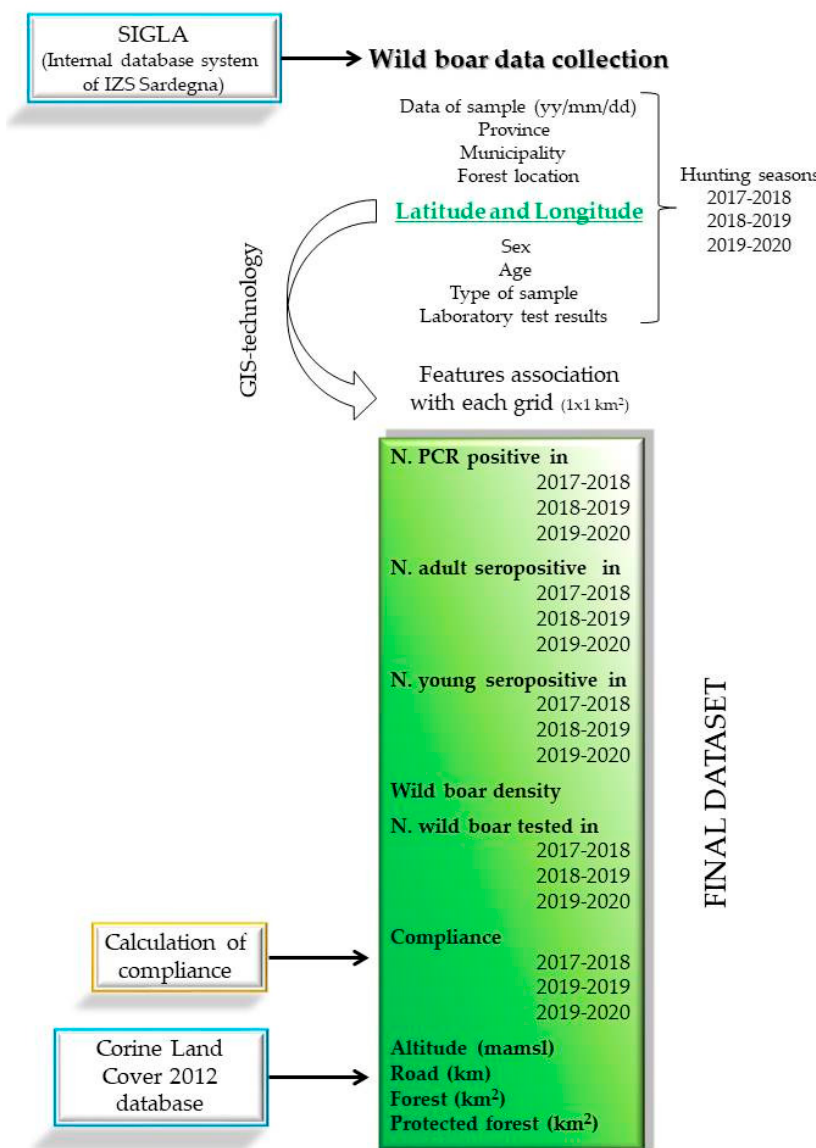
Figure 2. Flow-chart representing the study design methodology. Wild boar data were collected from the Internal database system (SIGLA) of Istituto Zooprofilattico Sperimentale della Sardegna. Based on latitude and longitude (green font), variables were associated with each grid of 1 km 2 by year, and the final dataset (green square) was implemented with the calculated compliance and the land features (altitude, road, forest, protected forest) collected by Corine Land Cover 2012 database.